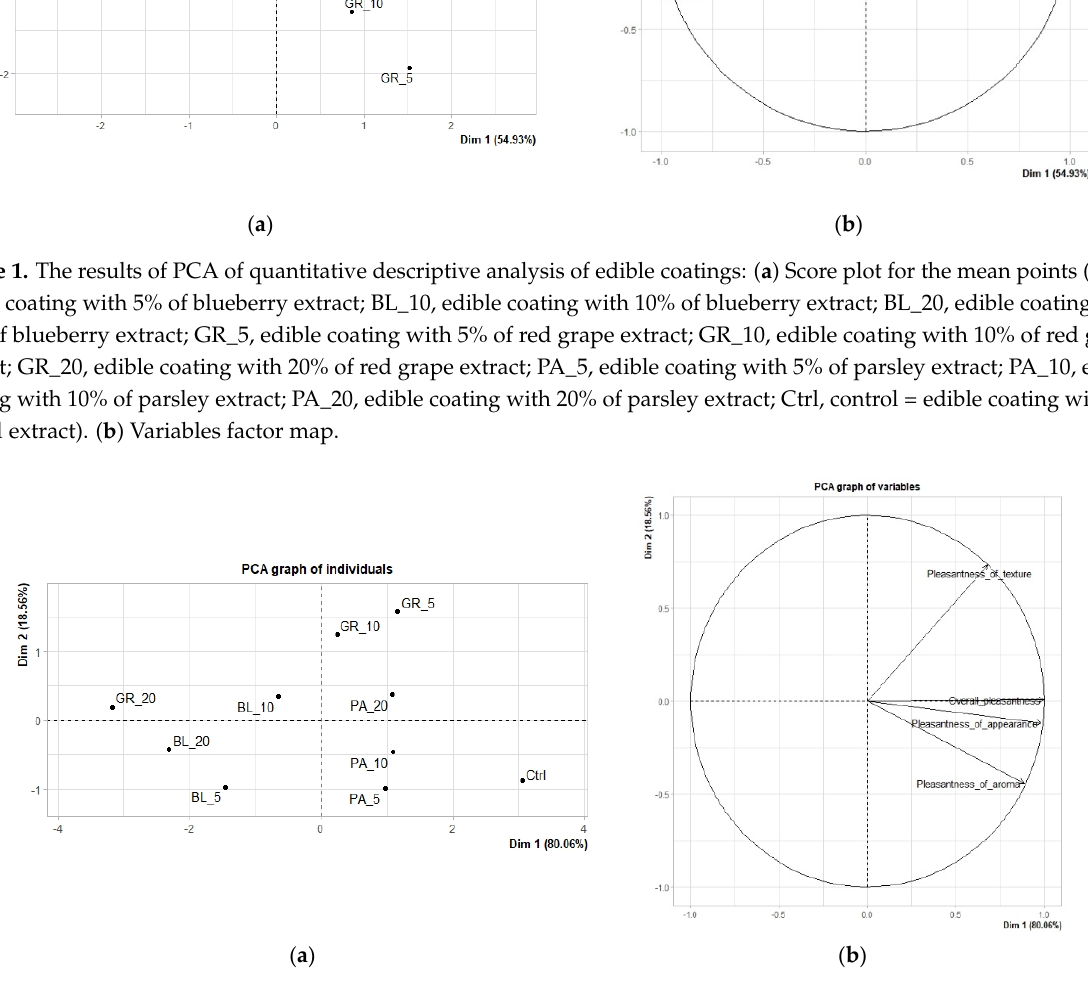
Figure 2. The results of PCA of hedonic analysis of edible coatings: ( a ) Score plot for the mean points (BL_5, edible coating with 5% of blueberry extract; BL_10, edible coating with 10% of blueberry extract; BL_20, edible coating with 20% of blueberry extract; GR_5, edible coating with 5% of red grape extract; GR_10, edible coating with 10% of red grape extract; GR_20, edible coating with 20% of red grape extract; PA_5, edible coating with 5% of parsley extract; PA_10, edible coating with 10% of parsley extract; PA_20, edible coating with 20% of parsley extract; Ctrl, control = edible coating without added extract). ( b ) Variables factor map.